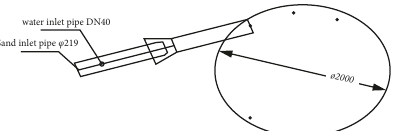
Figure 7: Schematic diagram of the flocculant addition point model for the central feed drum.